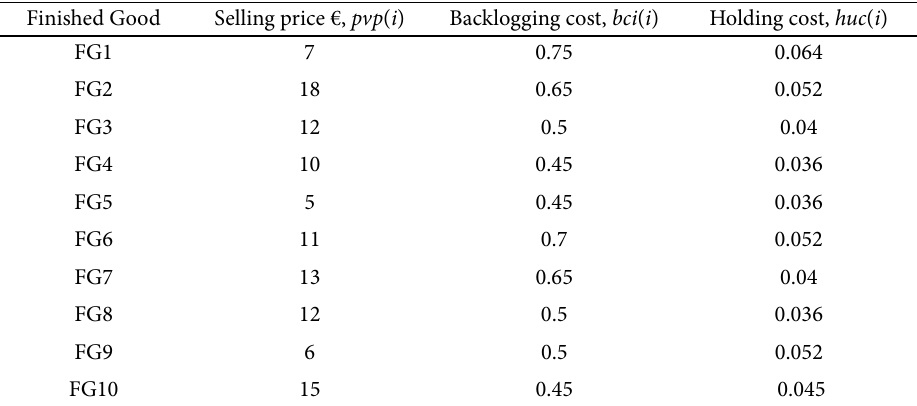
Table 3. Selling prices and costs for each FG